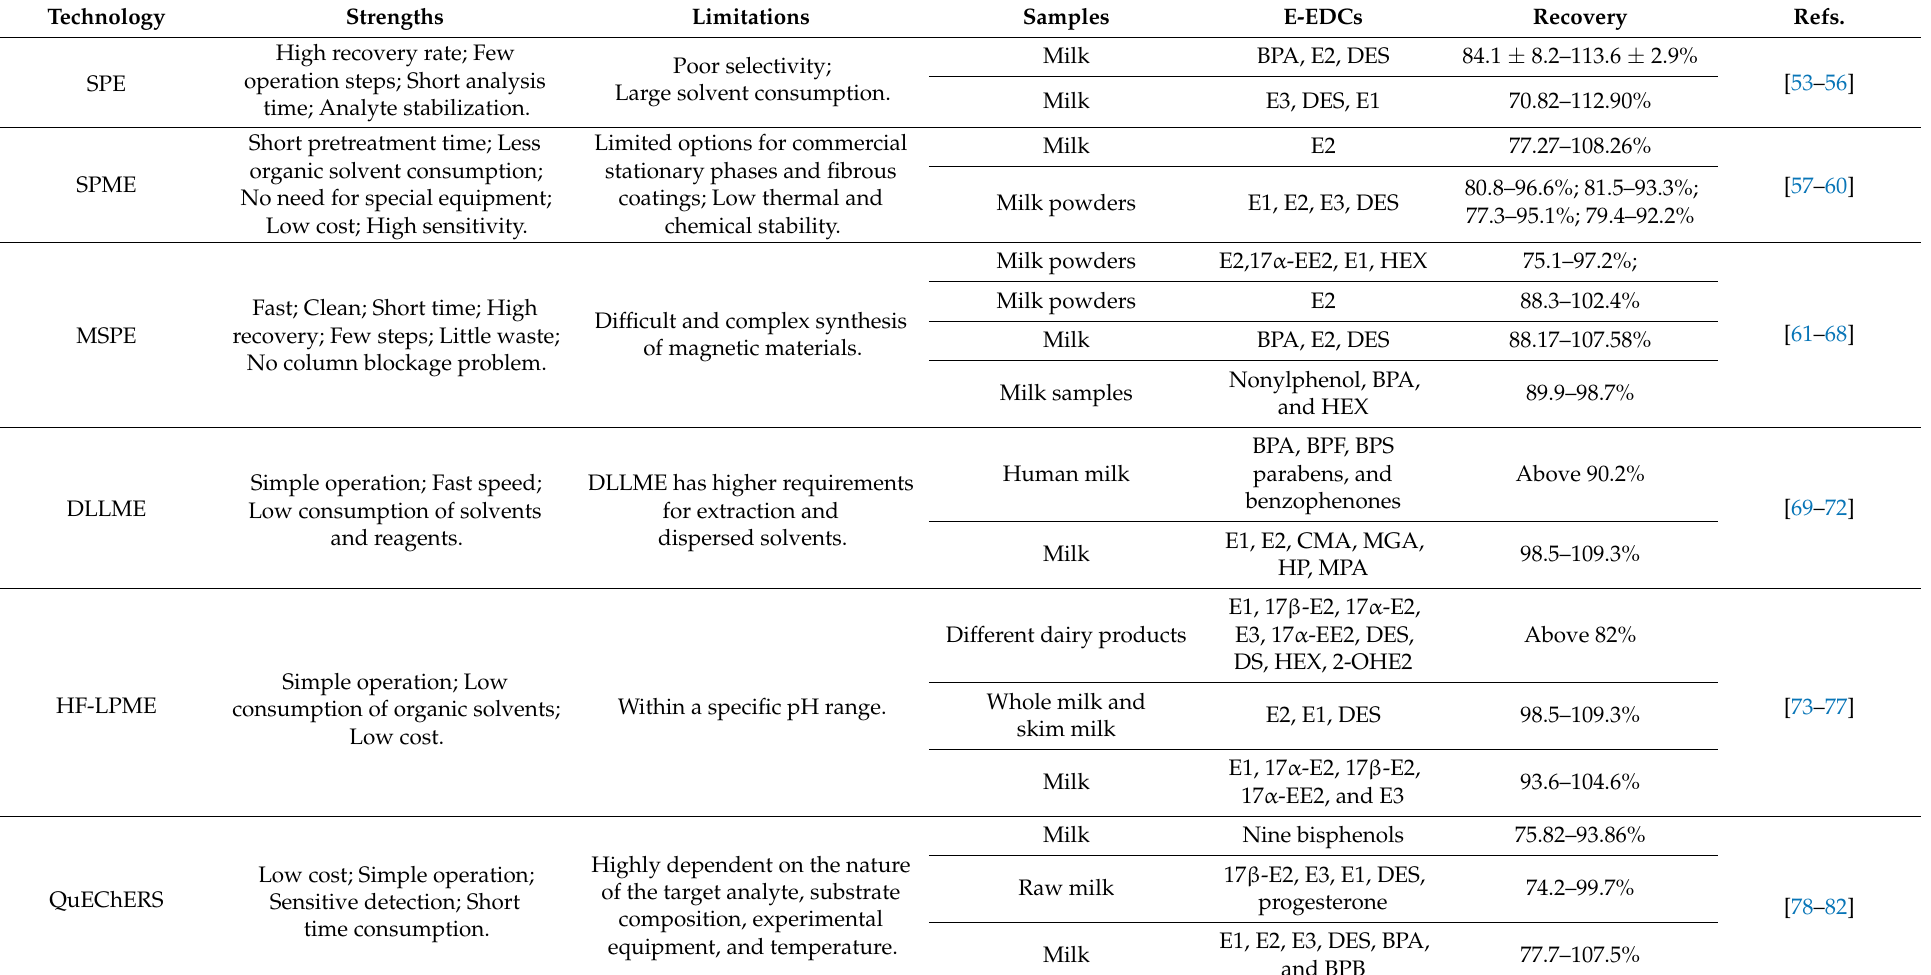
Table 2. Sample pretreatment methods of e-EDCs in milk and dairy